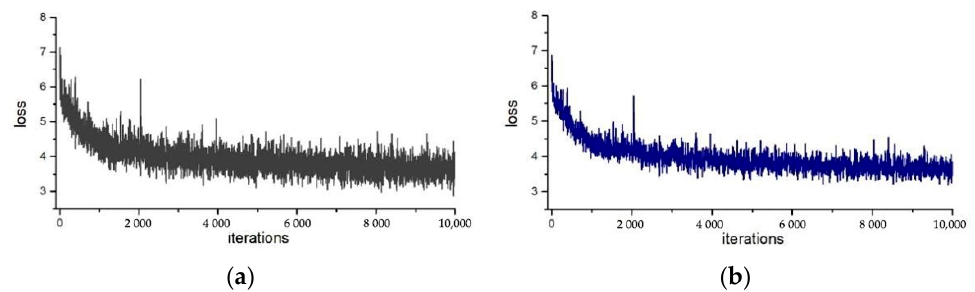
Figure 5. The loss curve of the ResNet101 network without and with the adaptive weighting.